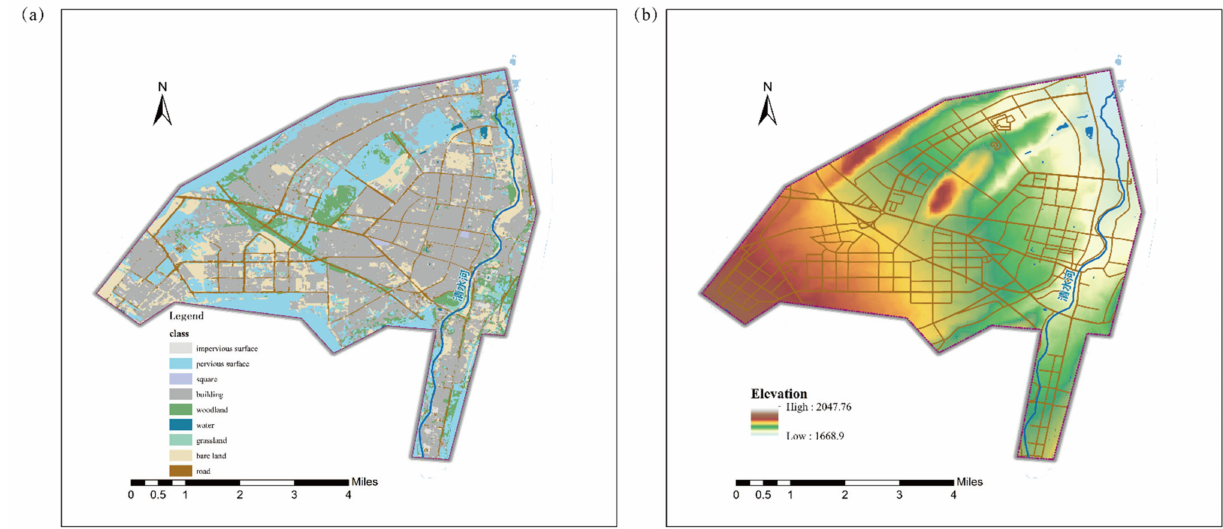
Figure 3. Basic data used in this study. ( a ) Land use types; ( b ) DEM data